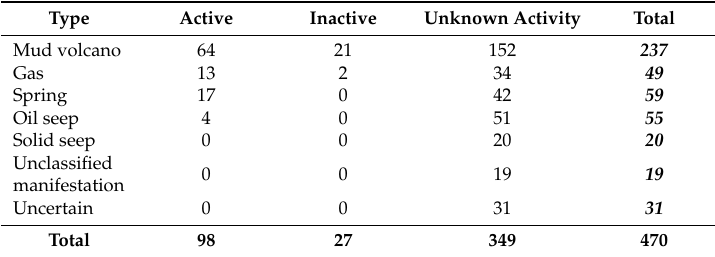
Table 2. Statistics of the HYSED-RO